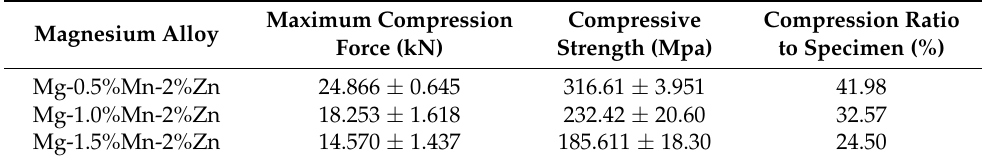
Table 3. Compression test of Mg-Mn-Zn alloy. Table 3 . Compression test of Mg-Mn-Zn alloy .